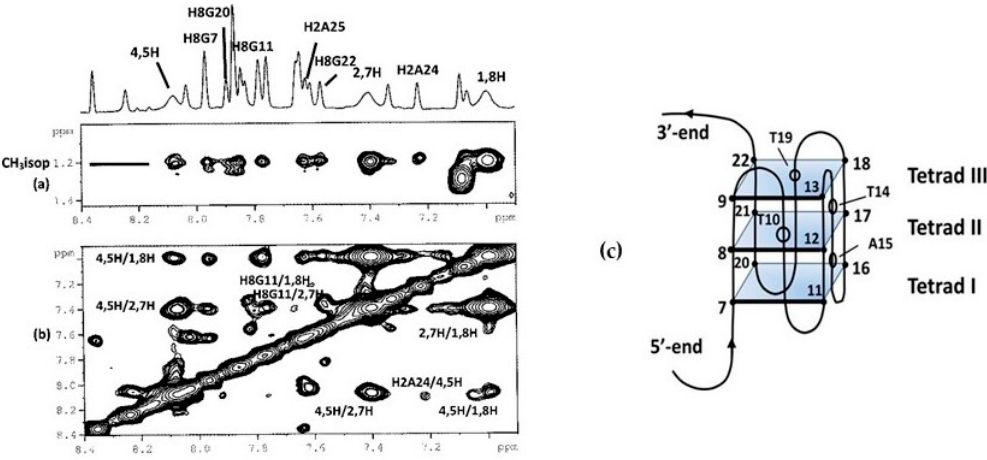
Figure 6. Selected region of the 2D NOESY spectrum of Pu22T14T23/curaxin complex. ( a ) Some aromatic protons of Pu22T14T23 display intermolecular NOEs with CH 3 (isopropyl) of curaxin; ( b ) some aromatic protons of Pu22T14T23 display intermolecular NOEs with aromatic protons of curaxin and ( c ) schematic representation of Pu22-T14 T23 oligomer G-quadruplex.